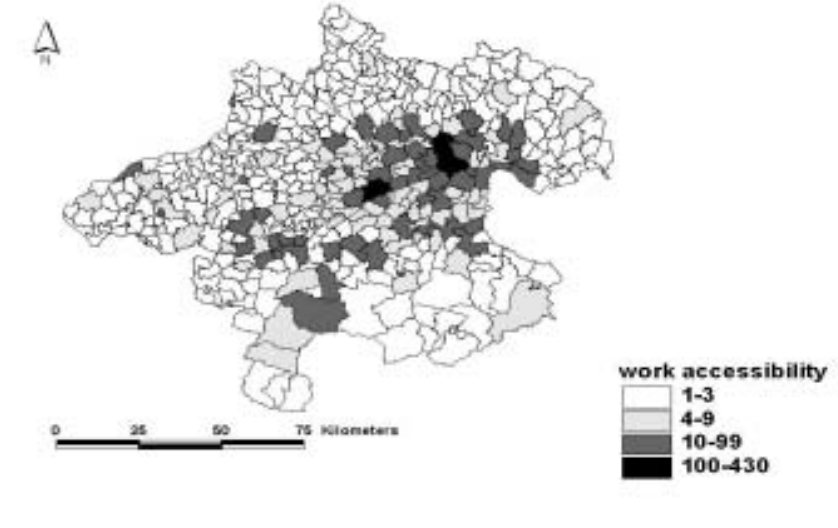
Figure 1. Spatial distribution of the work accessibility measure